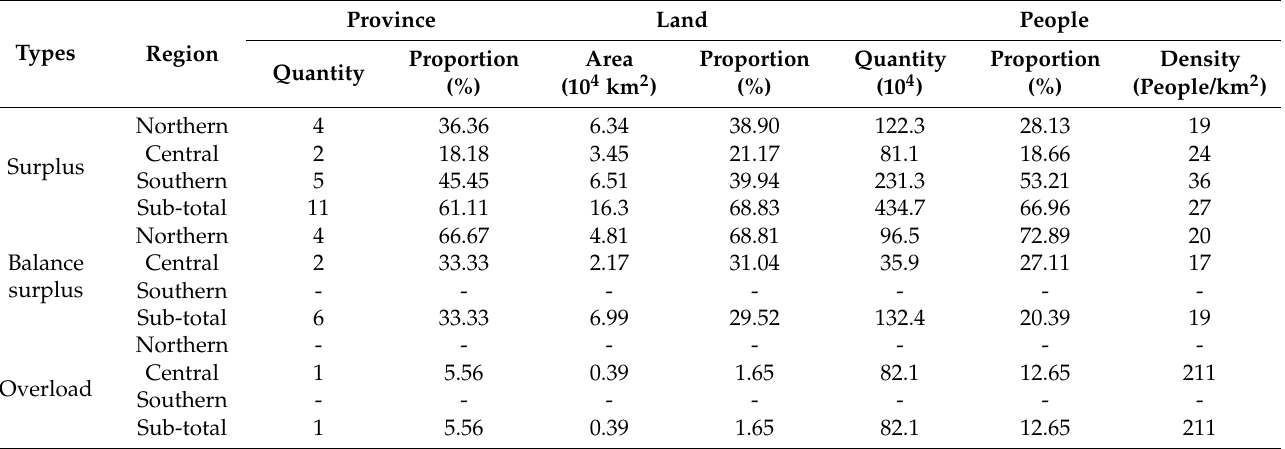
Figure 7. Spatial pattern of the ( a ) resource and environment restrictive classification, ( b ) ecological carrying status, ( c ) land resource bearing status, and ( d ) water resource bearing status in Laos. Table 3. Statistics of different resource carrying state regions in Laos.